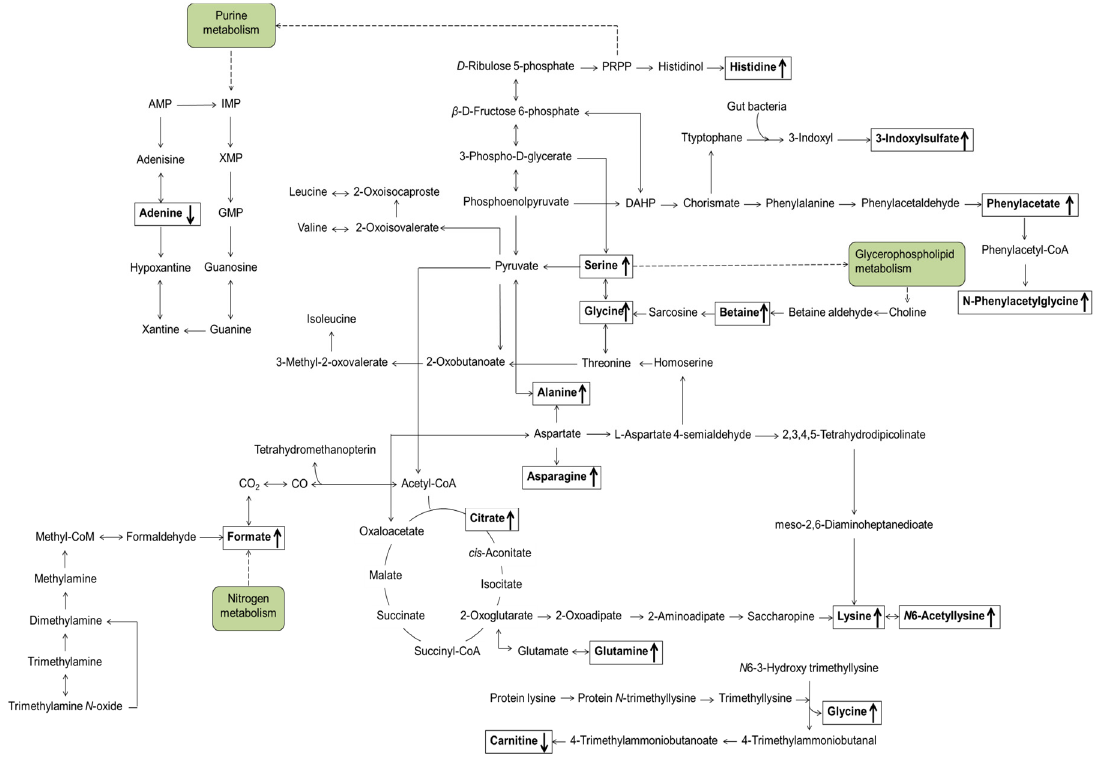
Figure 1. Proposed metabolic pathways related to endogenous urinary metabolites that were significantly changed in response to KBR administration over four weeks compared with those in the placebo group. Arrows indicate the directions of alterations. KBR, Korean black raspberry. Table 1. Significantly altered traditional metabolomics biomarkers in response to KBR consumption in sedentary overweight/obese adults 1